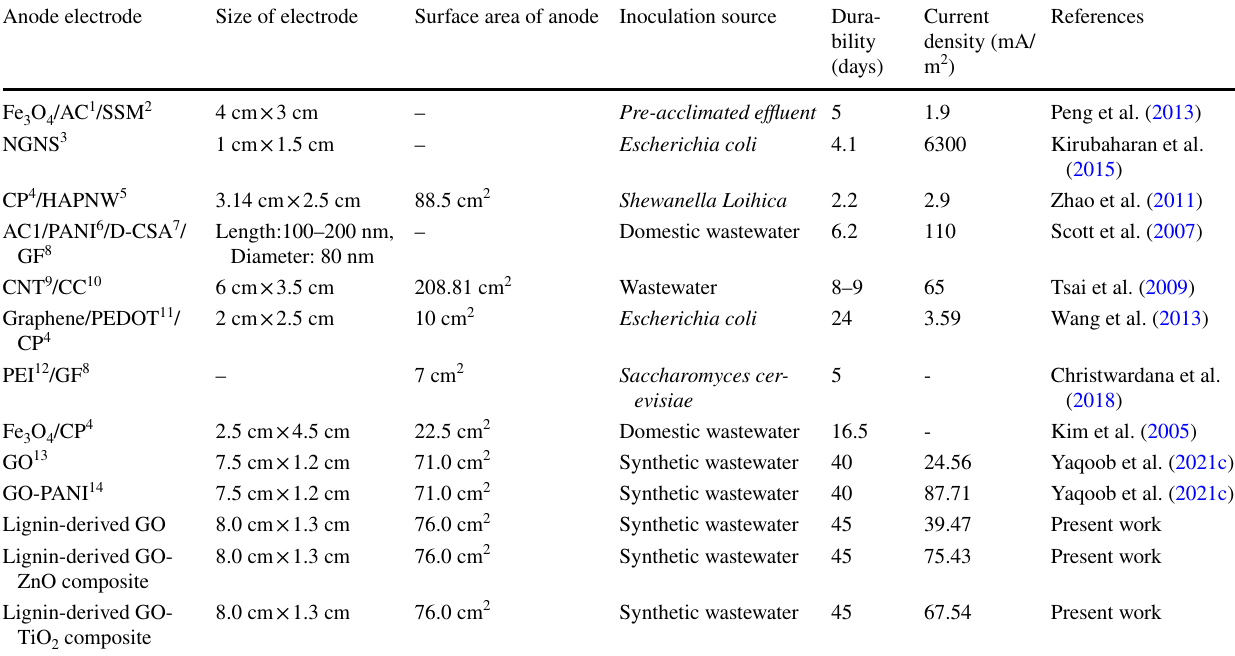
Table 3 Comparative summary of electrode durability and